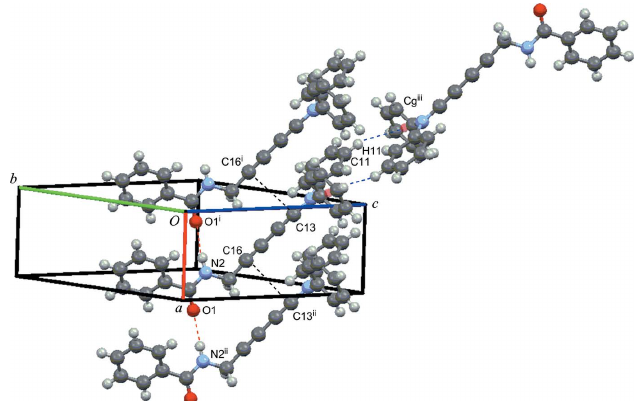
Figure 2 A view of the intermolecular interactions in the title compound [symmetry codes:(i) x (cid:5) 1, y , z ; (ii) x + 1, y , z ; (iii) (cid:5) x (cid:5) 1, (cid:5) y , (cid:5) z + 2]. Chains of molecules along the a axis with hydrogen bonds are drawn as red dashed line. Ring centroids are shown as red spheres and C— H (cid:3)(cid:3)(cid:3) (cid:2) (ring) contacts are drawn as blue dashed